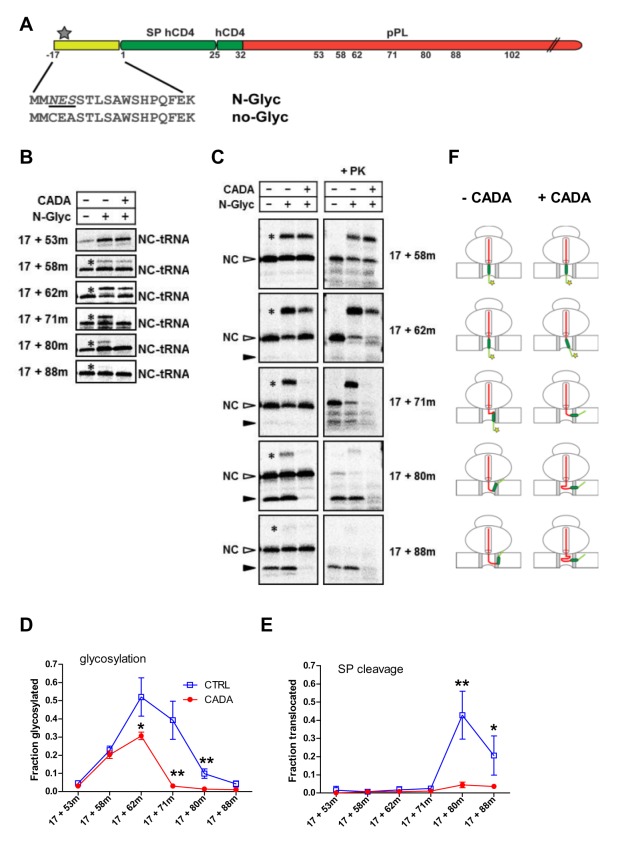
CADA locks the hCD4 SP in an intermediate inversion conformation in the translocon.(A) Line diagram of the constructs with an N-terminal extension of the SP lacking (no-Glyc) or containing a diagnostic glycosylation site (N-Glyc). For ease of comparison, the numbering refers to the non-extended WT hCD4 SP-containing polypeptide. The N-glycosylation site is underlined and the star indicates the N-glycosylated form of the protein. (B) Autoradiogram of truncated in vitro translated [35S]methionine-labelled [hCD4]-(7)-pPL RNCs with the glycosylation site-containing extension (N-Glyc). A non-glycosylation control (no-Glyc) is included (every first lane). Nascent chains were synthesized in the presence of RM, with or without CADA (15 µM). Samples were separated by SDS-PAGE and analyzed by autoradiography. Intact RNCs (NC-tRNA) and N-terminal glycosylated RNCs (asterisk) are indicated. Notice that CADA strongly inhibited the glycosylation of the 17+71-mer. (C) Same as in (B), but for the puromycin-treated samples. Equal aliquots of the translated material were left untreated or treated with PK. Released non-processed nascent chains (NC, open arrowhead), N-terminal glycosylated forms (asterisk) and signal-cleaved C-terminal translocated species (solid arrowhead) are indicated. (D) Fraction of glycosylated nascent chains in the absence or presence of CADA as in (C), quantified and plotted against chain length (n≥3). *p<0.05; **p<0.001. (E) Fraction of SP-cleaved C-terminal translocated nascent chains in the absence or presence of CADA as in (C), quantified and plotted against chain length (n≥3). *p<0.01; **p<0.001. (F) Schematic of ribosome/translocon complexes showing probable positioning of the SP of hCD4 in absence or presence of CADA. Star represents N-glycosylation.